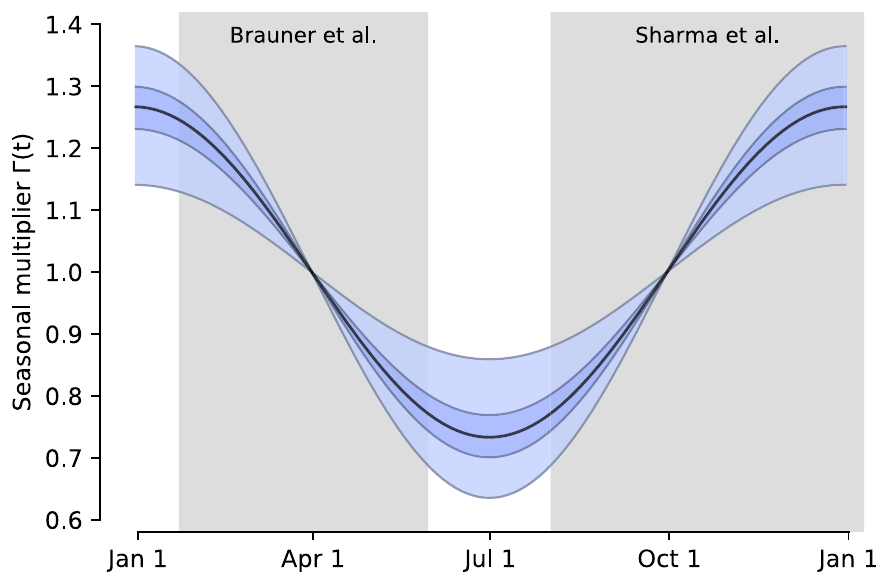
Fig 2. The inferred seasonal R multiplier Γ ( t ) of the combined models estimate, with 50% and 95% credible intervals. Gray boxes indicate data range of each dataset, i.e. 22nd January to 30th May 2020 for Brauner et al. and 1st August 2020 to 9th January 2021 for Sharma et al. The zero-width credible intervals around April 1 and October 1 owe to the fact that we model Γ ( t ) as a seasonal multiplier for R relative to the mid-spring and mid-fall, respectively, which implies that Γ ( t ) is assumed to be exactly equal to one for these